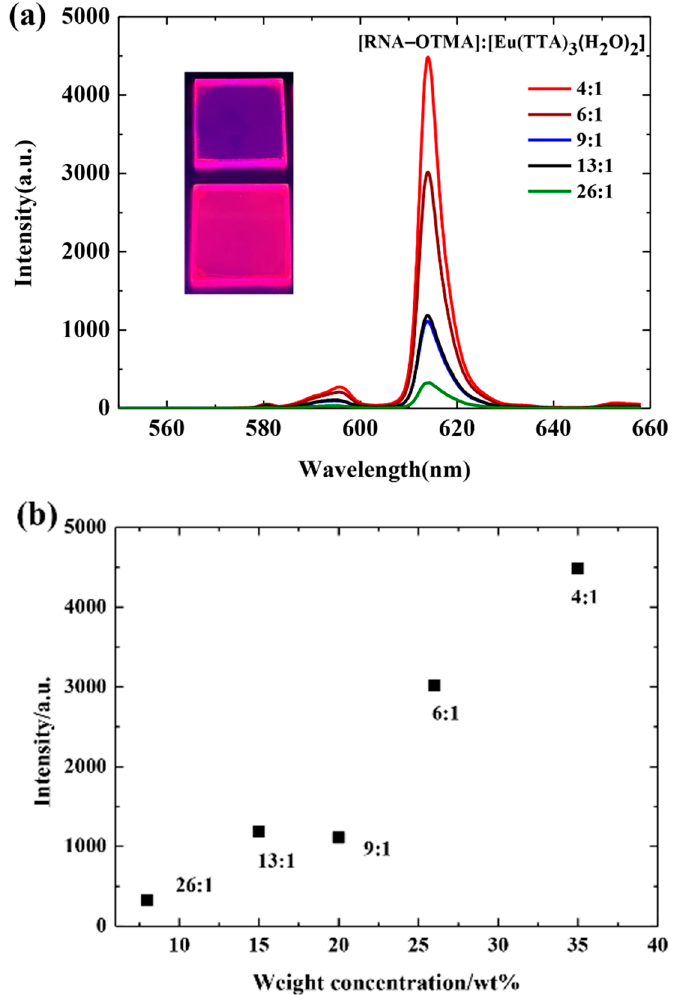
Figure 7. ( a ) Fluorescence emission spectra of different concentrations of Eu (TTA) 3 (H 2 O) 2 complexes in RNA–OTMA (extended figure shows the comparison of the luminescence of [RNA–OTMA]: [Eu (TTA) 3 (H 2 O) 2 ] = 0:1 film (top) and [RNA–OTMA]: [Eu (TTA) 3 (H 2 O) 2 ] = 4:1 film (bottom) under UV lamp). ( b ) Dot plot of luminescence.